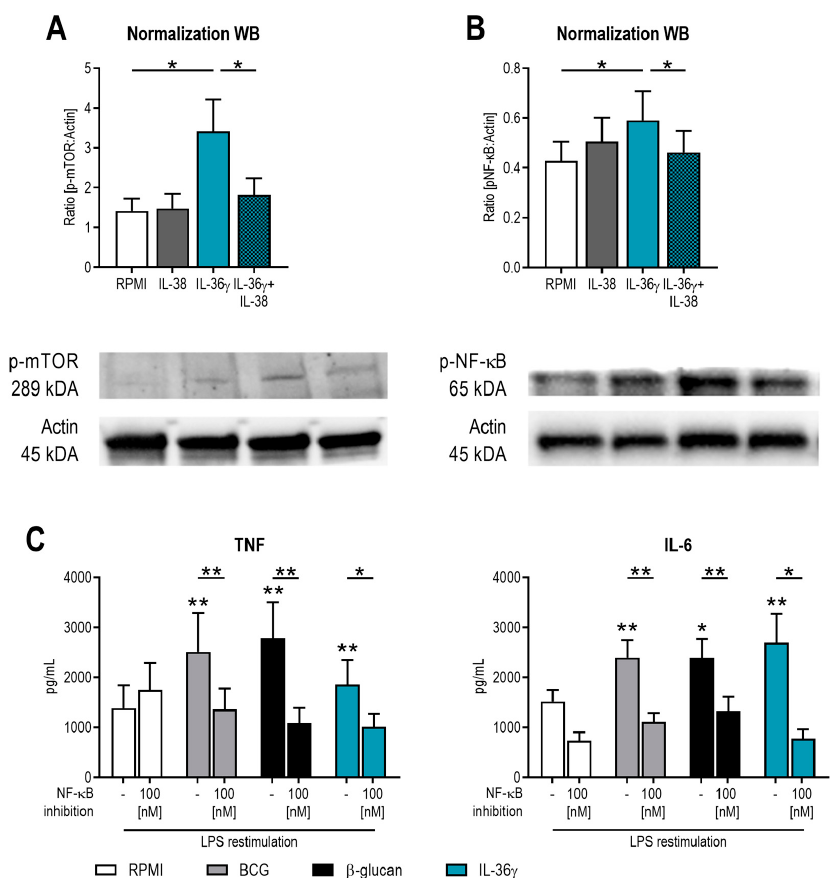
Figure 4. IL-36 γ induces phosphorylation of mTOR and NF- κ B. ( A , B ) Human monocytes were pre-incubated for 1 h with 90 ng/mL IL-38 before 50 ng/mL IL-36 γ was added to the medium. Phosphorylation of mTOR was determined after 2 h ( A ), and phosphorylation of NF- κ B was determined after 10 min ( B ) by Western blot. (Mean ± SEM, n = 4, Wilcoxon signed-rank test, * p < 0.05) ( C ). Human monocytes were incubated for 24 h with 2 μ g/mL β -glucan, 2 μ g/mL BCG, or 50 ng/mL IL-36 γ with or without an inhibitor of NK- κ B activation. After five days of rest in 10% human serum, cells were restimulated with LPS, and cytokine production was assessed in supernatants. (Mean ± SEM, n = 6,Wilcoxon signed-rank test, * p < 0.05, ** p < 0.01, either versus RPMI without NF- κ B inhibitor or versus the indicated condition.)